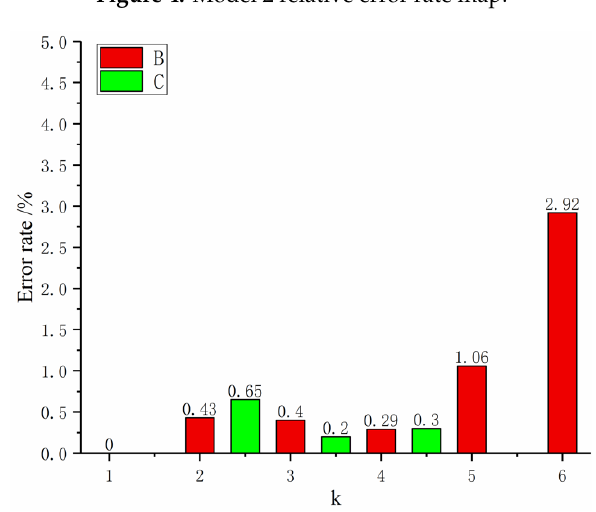
Figure 4. Model 2 relative error rate map.